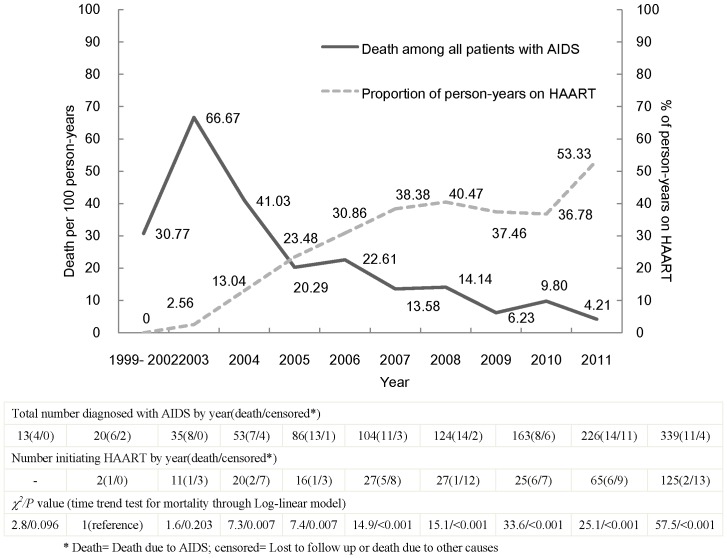
Mortality over time for AIDS patients included in the study.